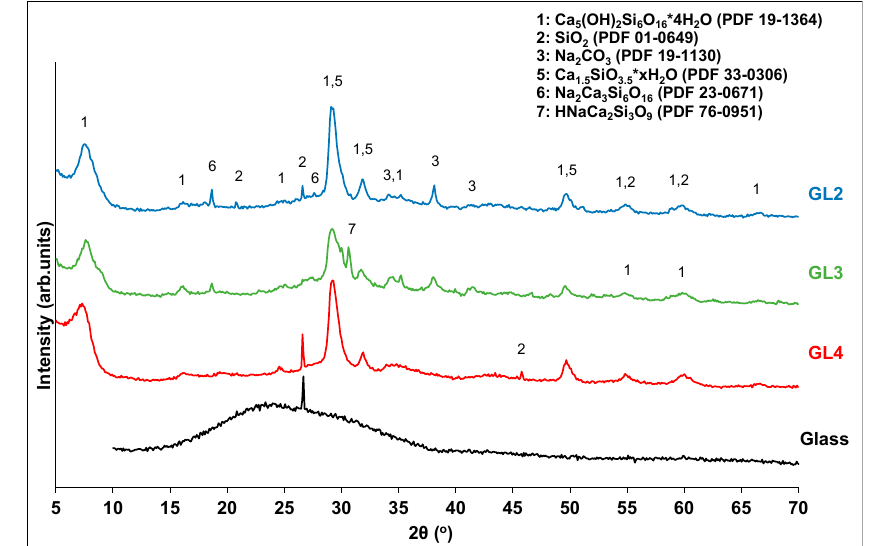
Figure 9. XRD analysis of glass waste and selected solid residues.